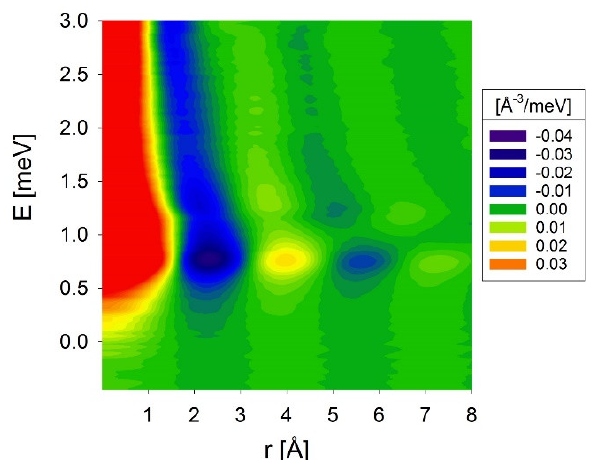
Figure 2. Dynamic pair-density function (DyPDF) of 4 He liquid at T = 1.83 K [29].